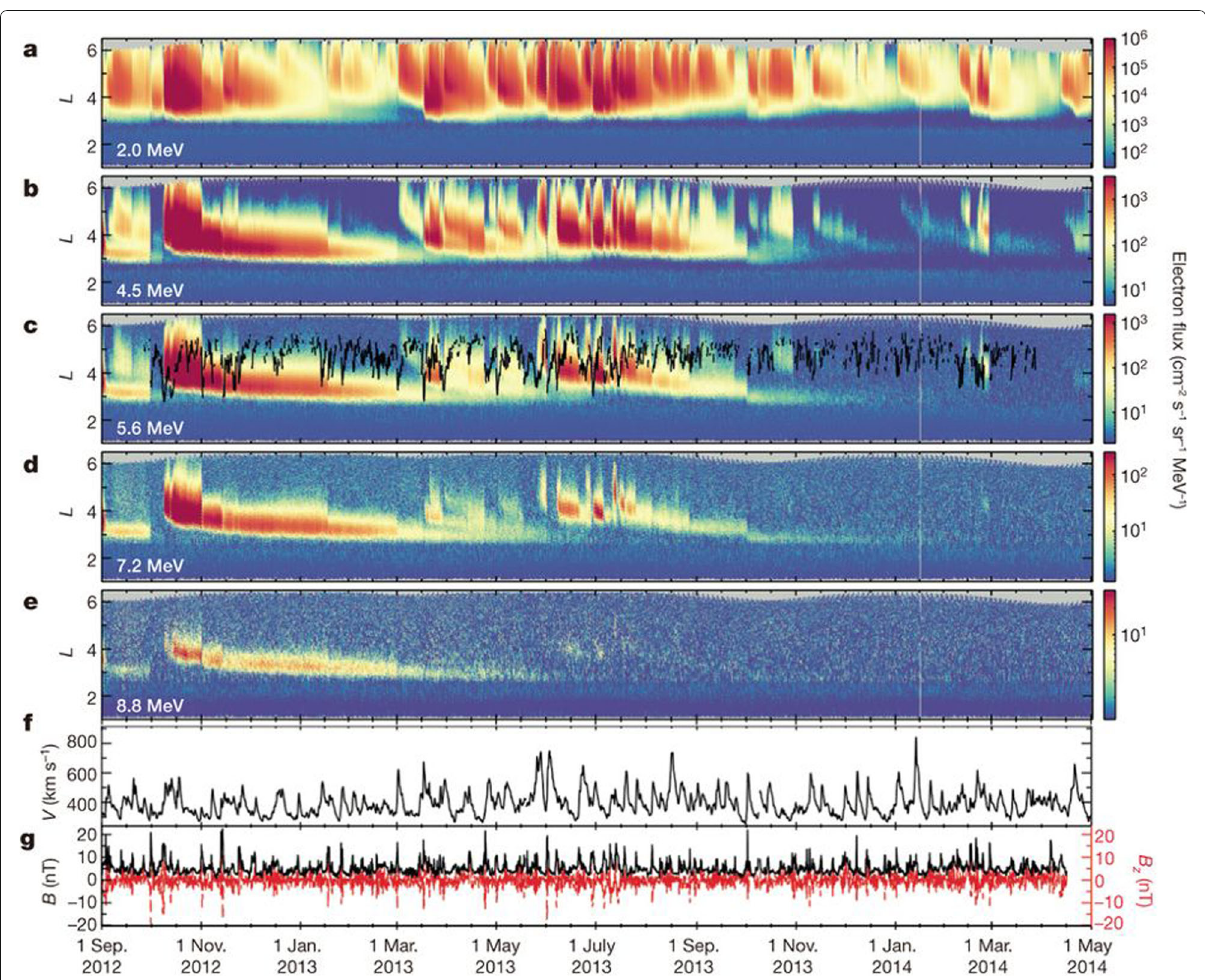
Fig. 4 The “impenetrable barrier” for relativistic electrons as observed by the REPT instrument on Van Allen Probes (reproduced from Baker et al. (2014a)). At all energies, inward radially diffusing electrons do not penetrate below L ≈